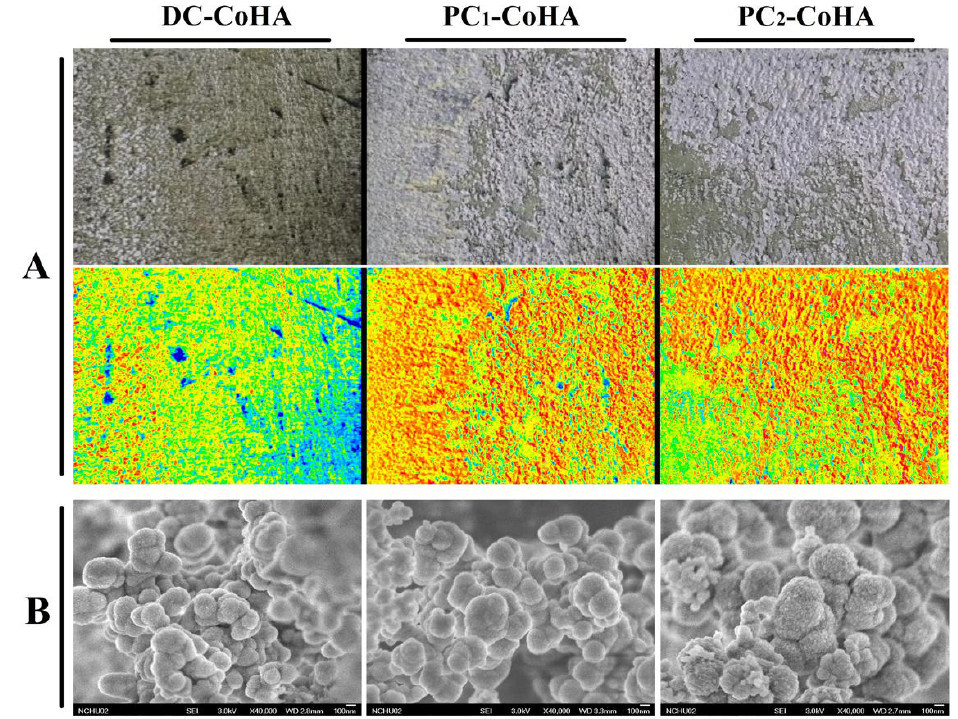
Figure 2. The surface morphology of the Co-HA particles was observed by ( A ) camera and ( B ) field-emission scanning electron microscope (FE-SEM). The color map is obtained using the surface image via Image J software analysis and red represents the distribution of Co-HA. Table 2. The construct parameters of the as synthesized CoHA particles by X-ray diffraction (XRD) analysis.